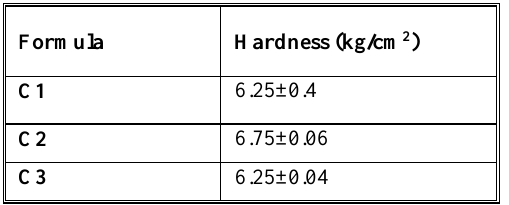
Table 6. Post formulation results of press coated core tablet of sumatriptan